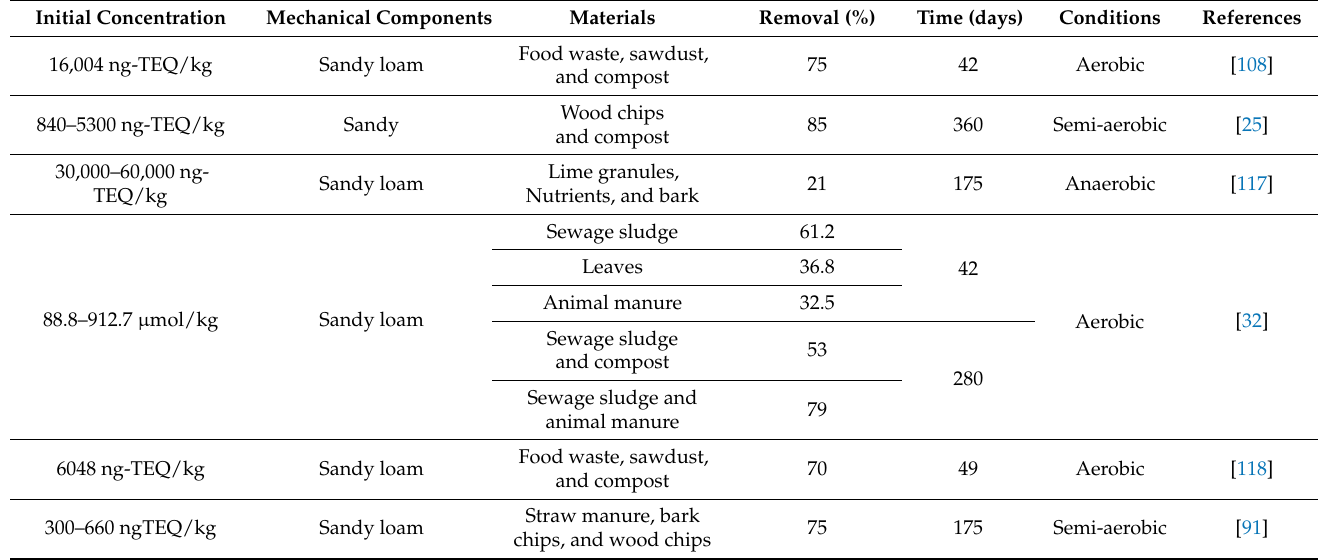
Table 6. Summary of biodegradation statistics for dioxins in contaminated soil.